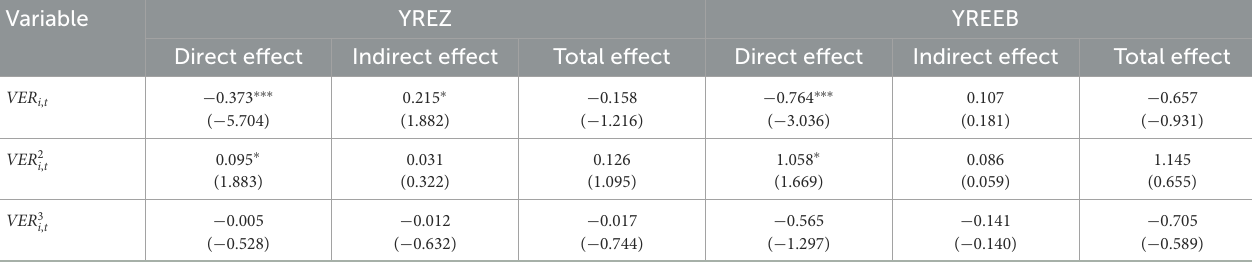
TABLE 12 Decomposition results of effects of VER on GDE in two economic belts. Variable